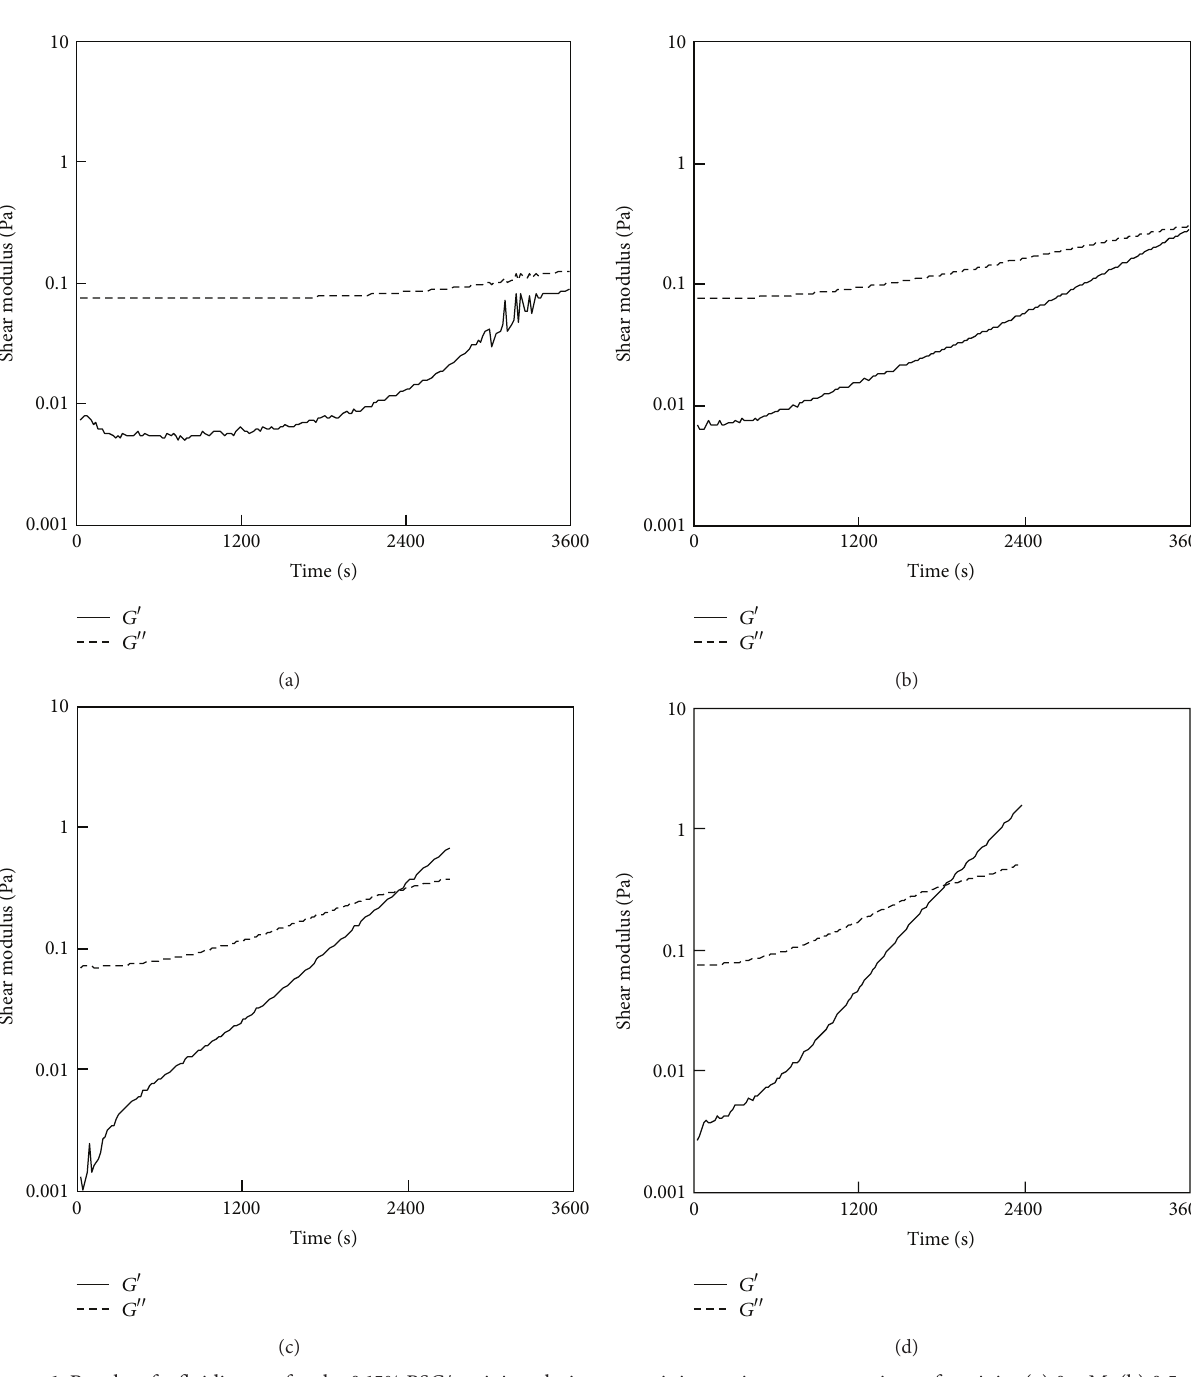
Figure 1: Results of a fluidity test for the 0.15% PSC/genipin solutions containing various concentrations of genipin: (a) 0mM, (b)